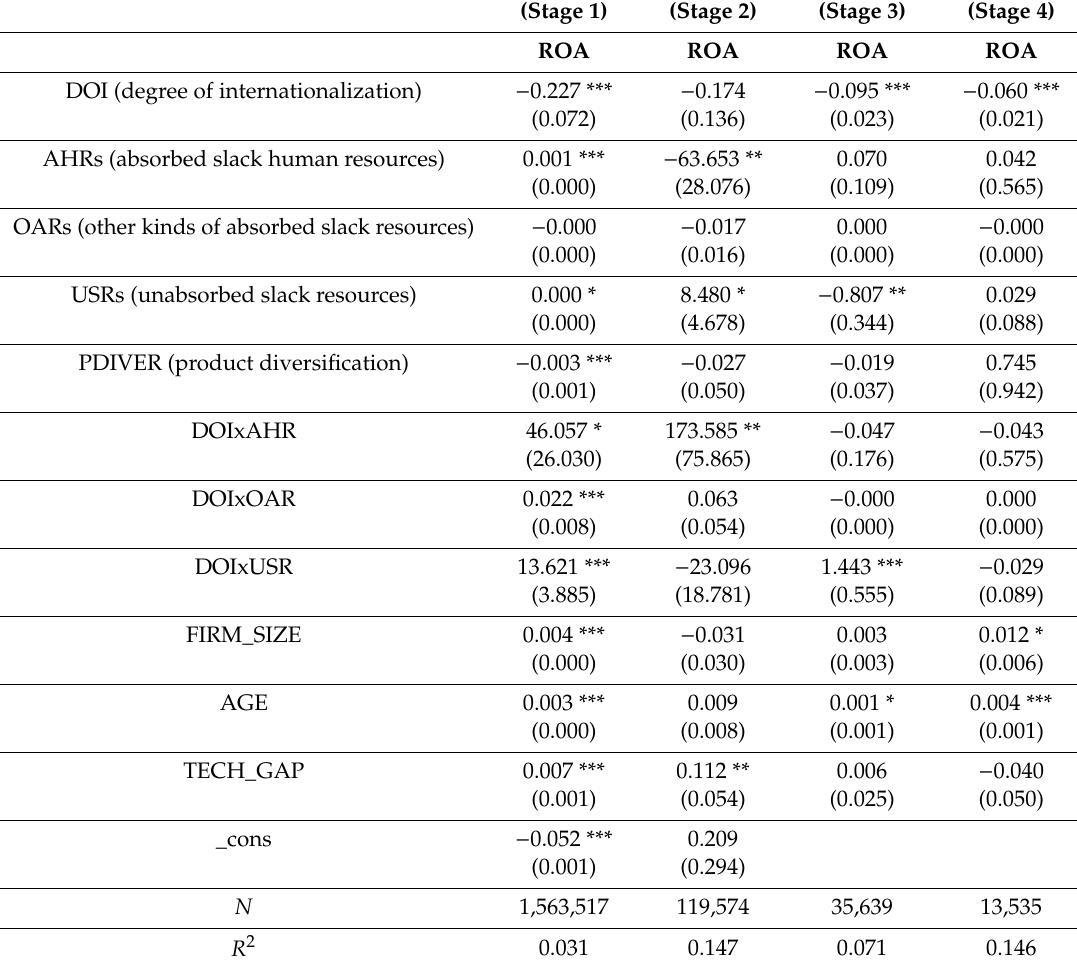
Table 4. The moderating e ff ects of AHRs, OARs, and USRs across the four stages of internationalization. (Stage 1) (Stage